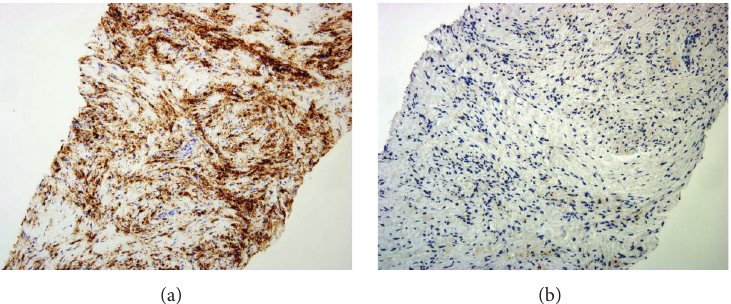
Figure 6: Retroperitoneal biopsy: immunohistochemical stain showing positivity for CD68 (a) and negativity for S100 (b).